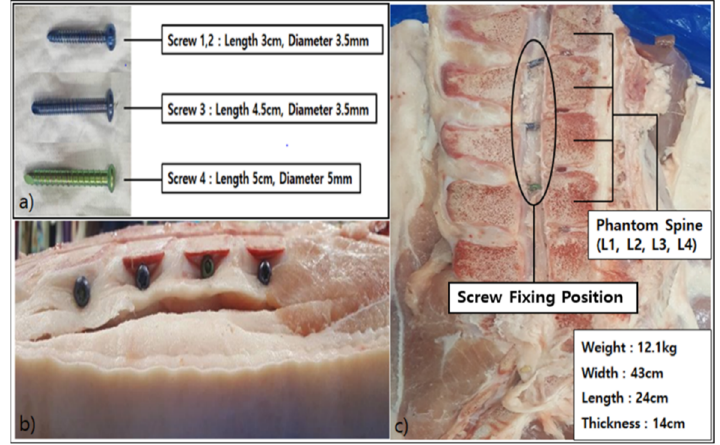
Figure 1. Production of Pig L-spine Phantom. This shows the overall shape of fixation of the screw position in the side of L1–L4 and the sagittal plane. Screw shape and dimensions ( a ); Image of the side of the region where the Screw is fixed ( b ); Dimensions of the Phantom and the sagittal section in which the Screw is fixed by designating L1, L2, L3, and L4 ( c ).